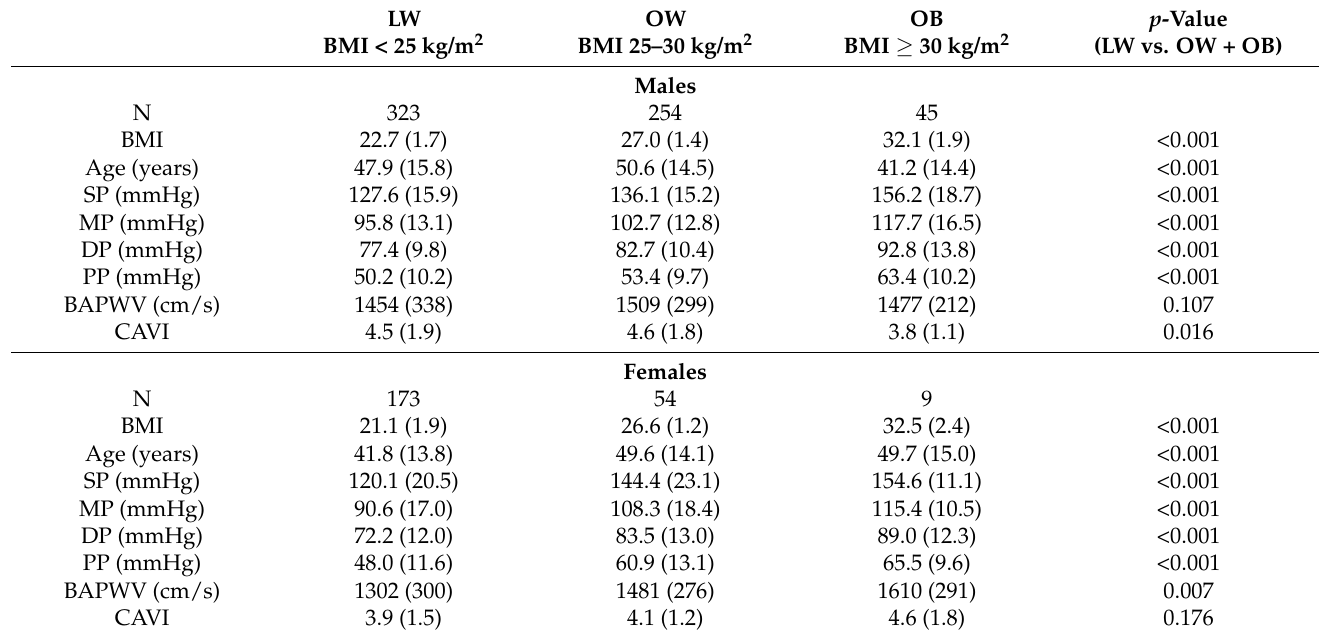
BMI = Body Mass Index, LW = lean weight, OW = overweight, OB = obese, p -value was the signifi- cance level between LW and OW + OB due to the low numbers. SP = Brachial Systolic Pressure, MP = Brachial Mean Pressure (by integration), DP = Brachial Diastolic Pressure, PP = Brachial Pulse Pressure, BAPWV = brachial–ankle Pulse Wave Velocity.